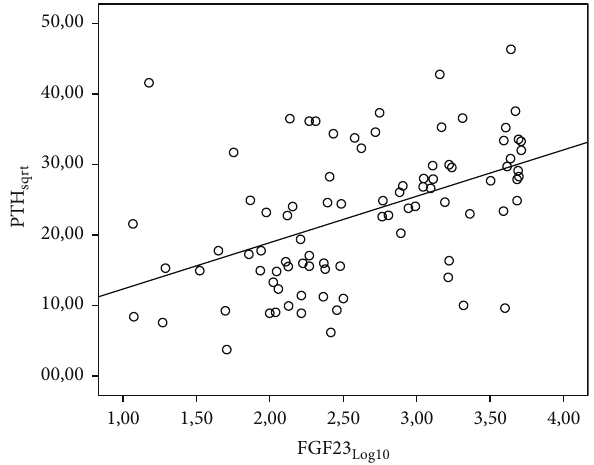
Figure 1: Relationship between FGF-23 and iPTH